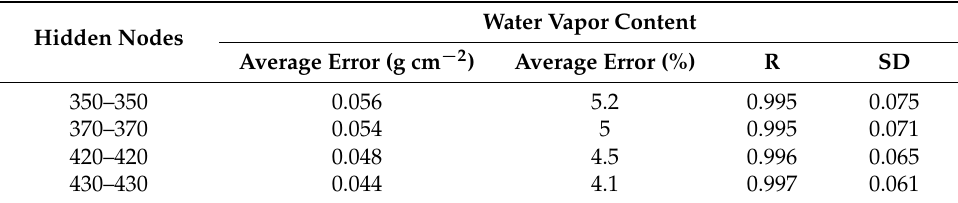
Table 3. Summary of retrieval